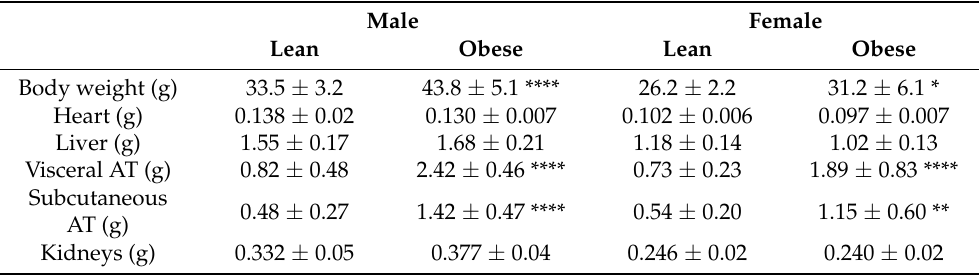
Table 5. Body weights and organ weights of lean and obese C57BL/6N mice (18 weeks old). Male Female Lean Obese Lean Obese Body weight